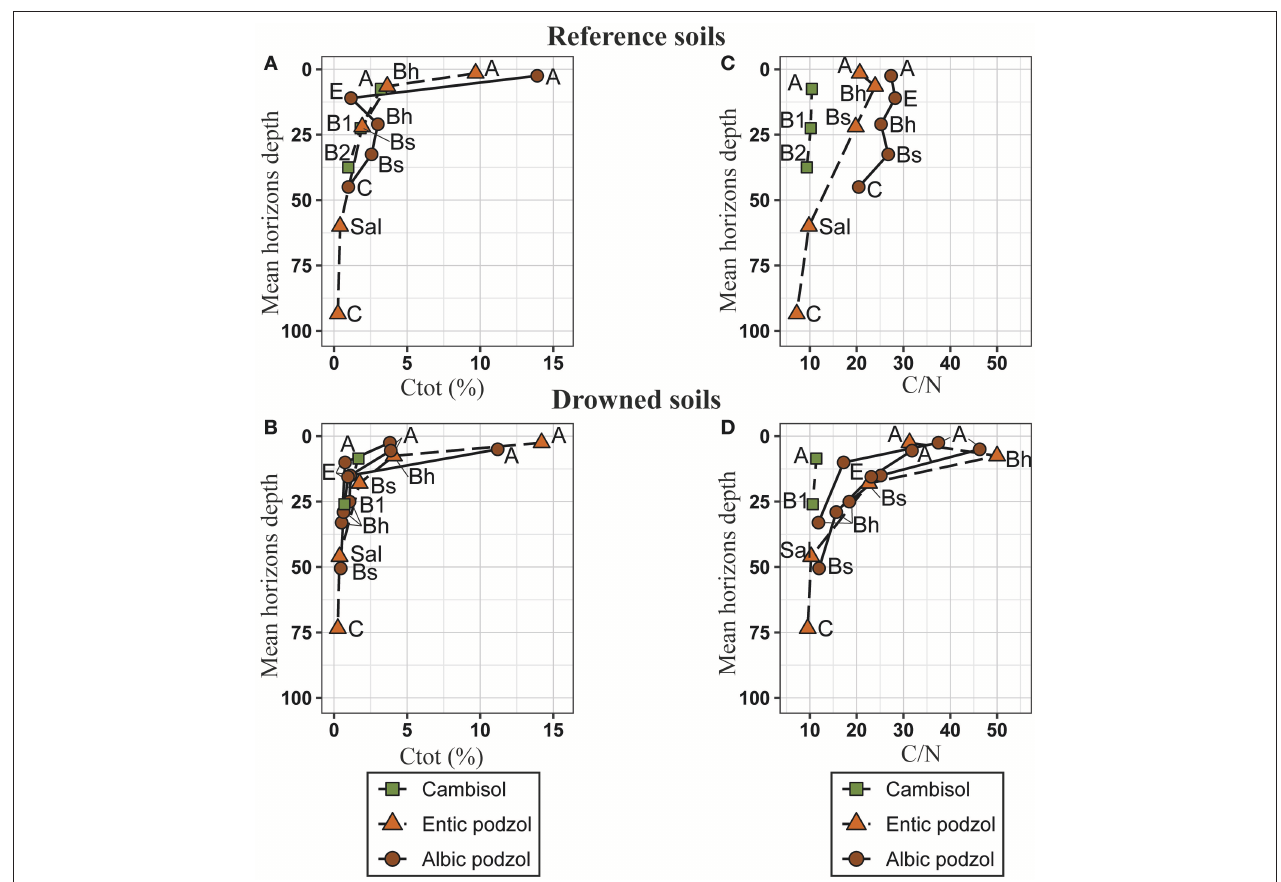
FIGURE 3 | Total organic content (Ctot) of the horizons of reference soils (A) and drowned soils (B) . Carbon/nitrogen (C/N) ratio (wt/wt) of the horizons of reference soils (C) and drowned soils (D) . Holorganic horizons are not shown. Green square: Cambisol. Orange triangle: Entic Podzol. Brown dot: Albic Podzol. Horizon names are specified beside each